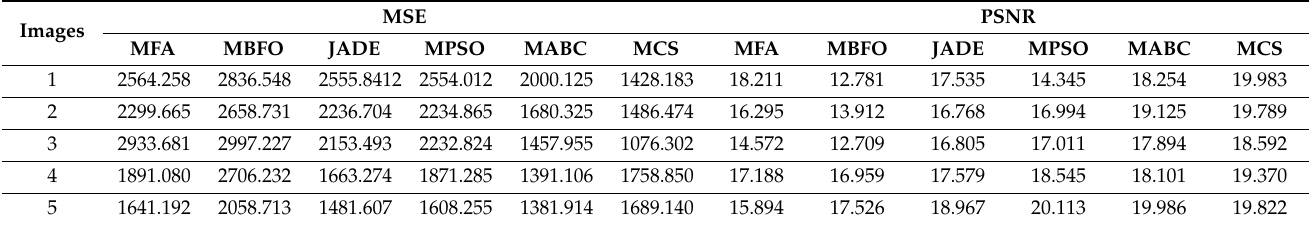
Table 3. MSE and PSNR values computed using different optimization algorithms with the EC-Otsu method. Images